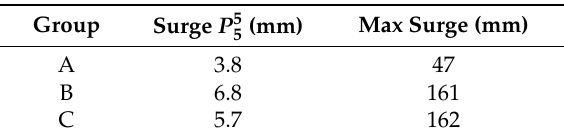
Table 4. Surge P 5 values. The maximum values are the average of the peak surge values for the five 5 repetitions in each